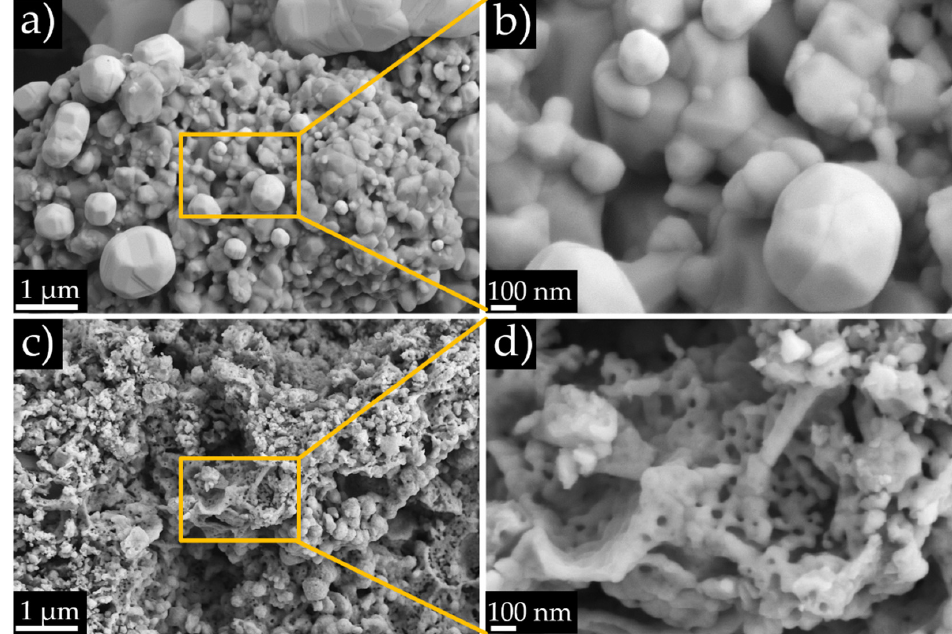
Figure 4. Representative region of the scaffold of the 10-CGO cell ( a ). SEM micrograph at a higher magnification ( b ). Representative region of the infiltrated scaffold of the 10-CGO meso cell ( c ). SEM micrograph at a higher magnification ( d ) where the residual mesoporosity can be observed.